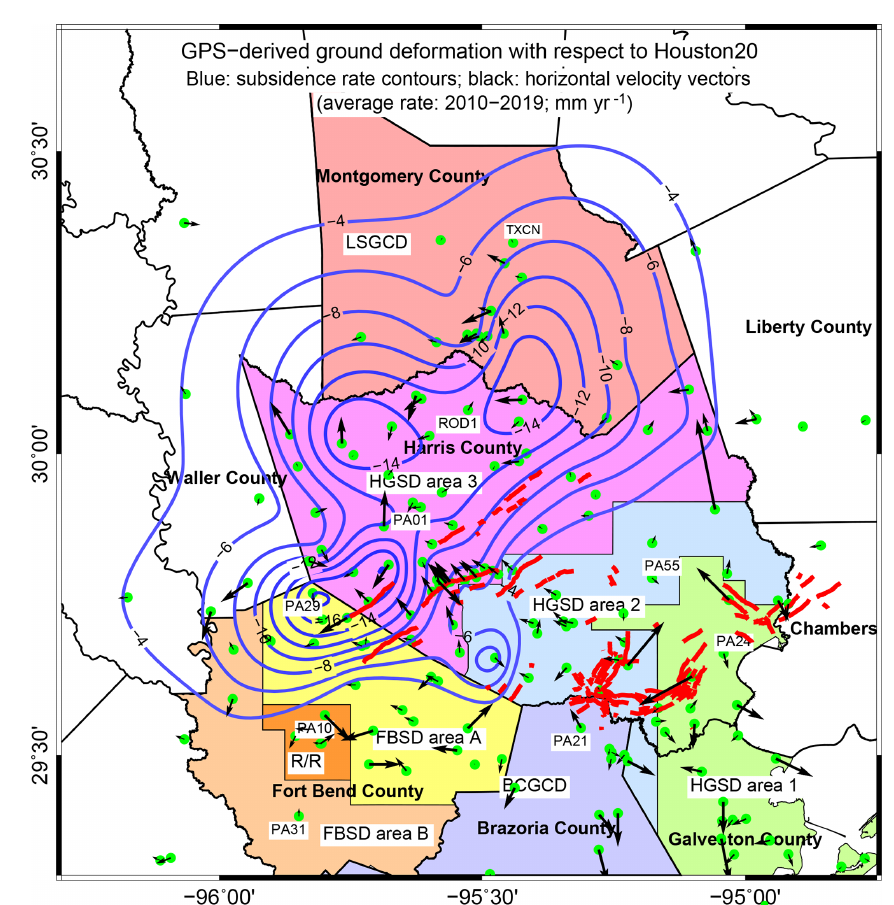
Figure 4. Map depicting subsidence-rate contours (mmyr − 1 ) and horizontal velocity vectors (with respect to Houston20) derived from GPS observations within the period from 2010 to 2019. The colored areas represent the groundwater regulation